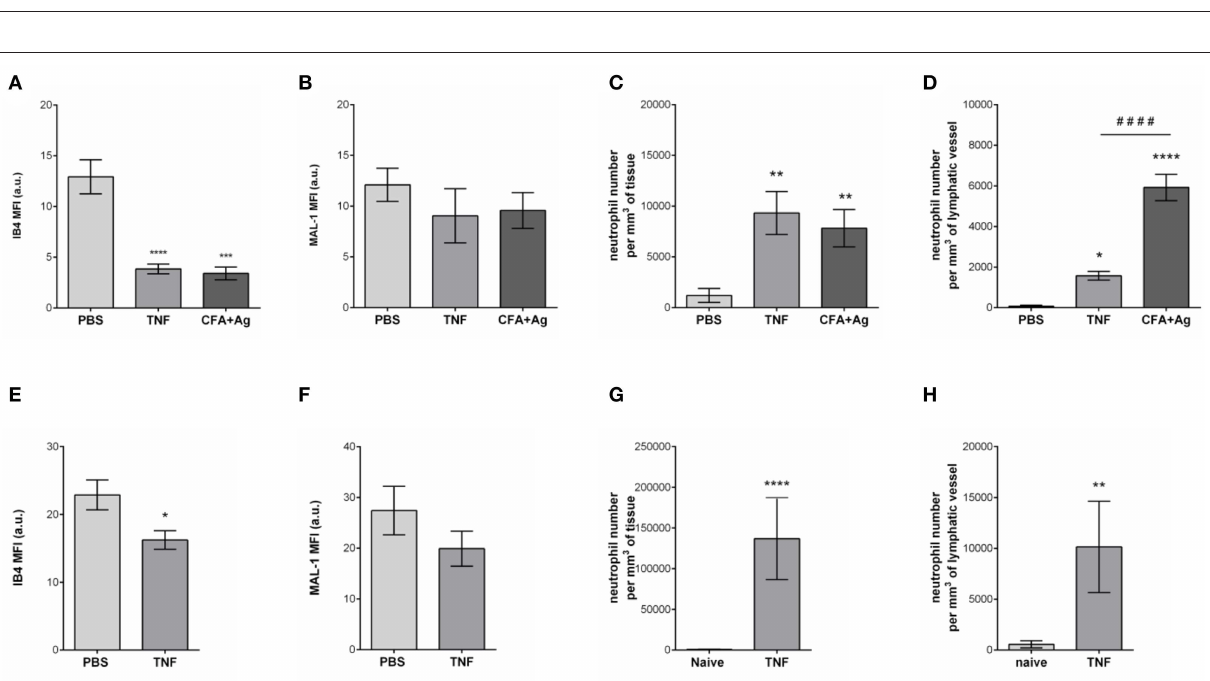
FIGURE 4 | The image on the far right is a transversal cross-section view of the TNF-stimulated tissue image along the dotted line and showing the entry of a neutrophil (arrow) within the lymphatic vessel. (B) Representative 3D-reconstructed confocal images of an initial lymphatic vessel from a TNF-stimulated tissues. The right hand side panel is a longitudinal cross-section of the lymphatic capillary demonstrating the presence of numerous neutrophils (arrows) within the lymphatic vessel. (C) Quantification of the number of neutrophils that have infiltrated the interstitial tissues (per mm 3 of tissue). (D) Quantification of the number of neutrophils present within lymphatic vessels (per mm 3 of lymphatic vessel). (E) Quantification of the Mean Fluorescence Intensity (MFI) of HS expression on lymphatic vessels following PBS and TNF stimulation. Results are from n = 8–12 vessels per mouse with 3–6 animals per group. Statistically significant differences between isotype control PBS and TNF-treated groups are indicated by asterisks: * P < 0.05, ** P < 0.01, *** P < 0.001. Bars = 50 µ m.